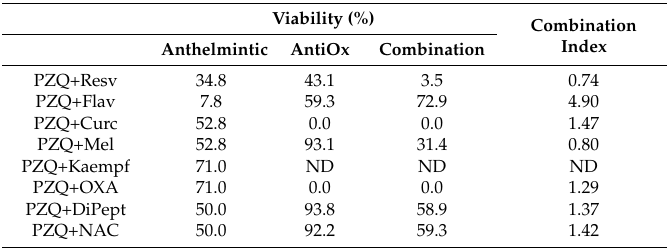
Table 5. Viability of NTS (%) following exposure to PZQ, antioxidant and combination and its cooperative